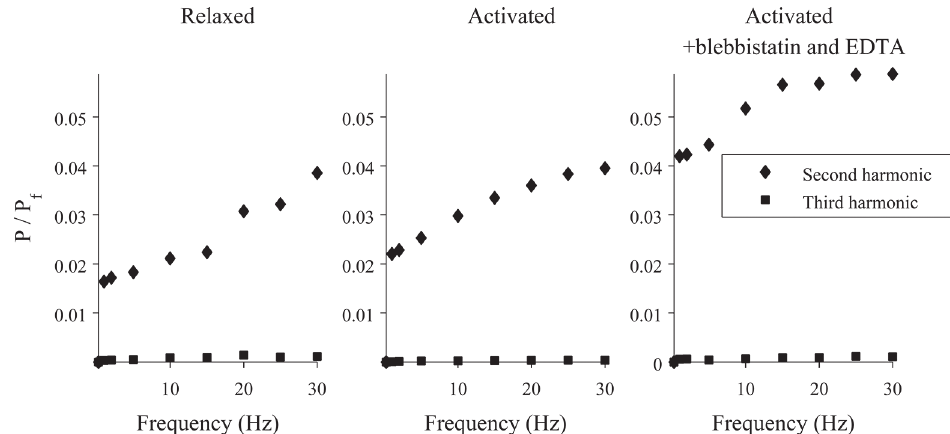
Fig 2. Frequency components of the force signal for a muscle fiber experiencing sinusoidal oscillations. A Fourier transform was applied to the force measurement time-courses, and the powers of the signal at the fundamental frequency (which is the same as the driving frequency) and the next two harmonics were calculated. Plotted are the ratios of the power at the second or third harmonic ( P ) and the power at the fundamental frequency ( Pf ) for three different experimental